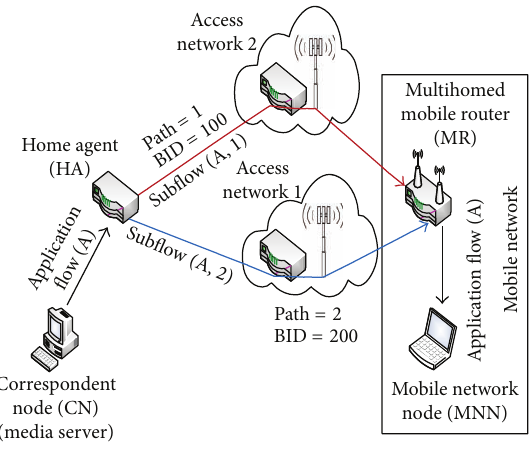
Figure 5: Application subflow to NEMO BID binding.